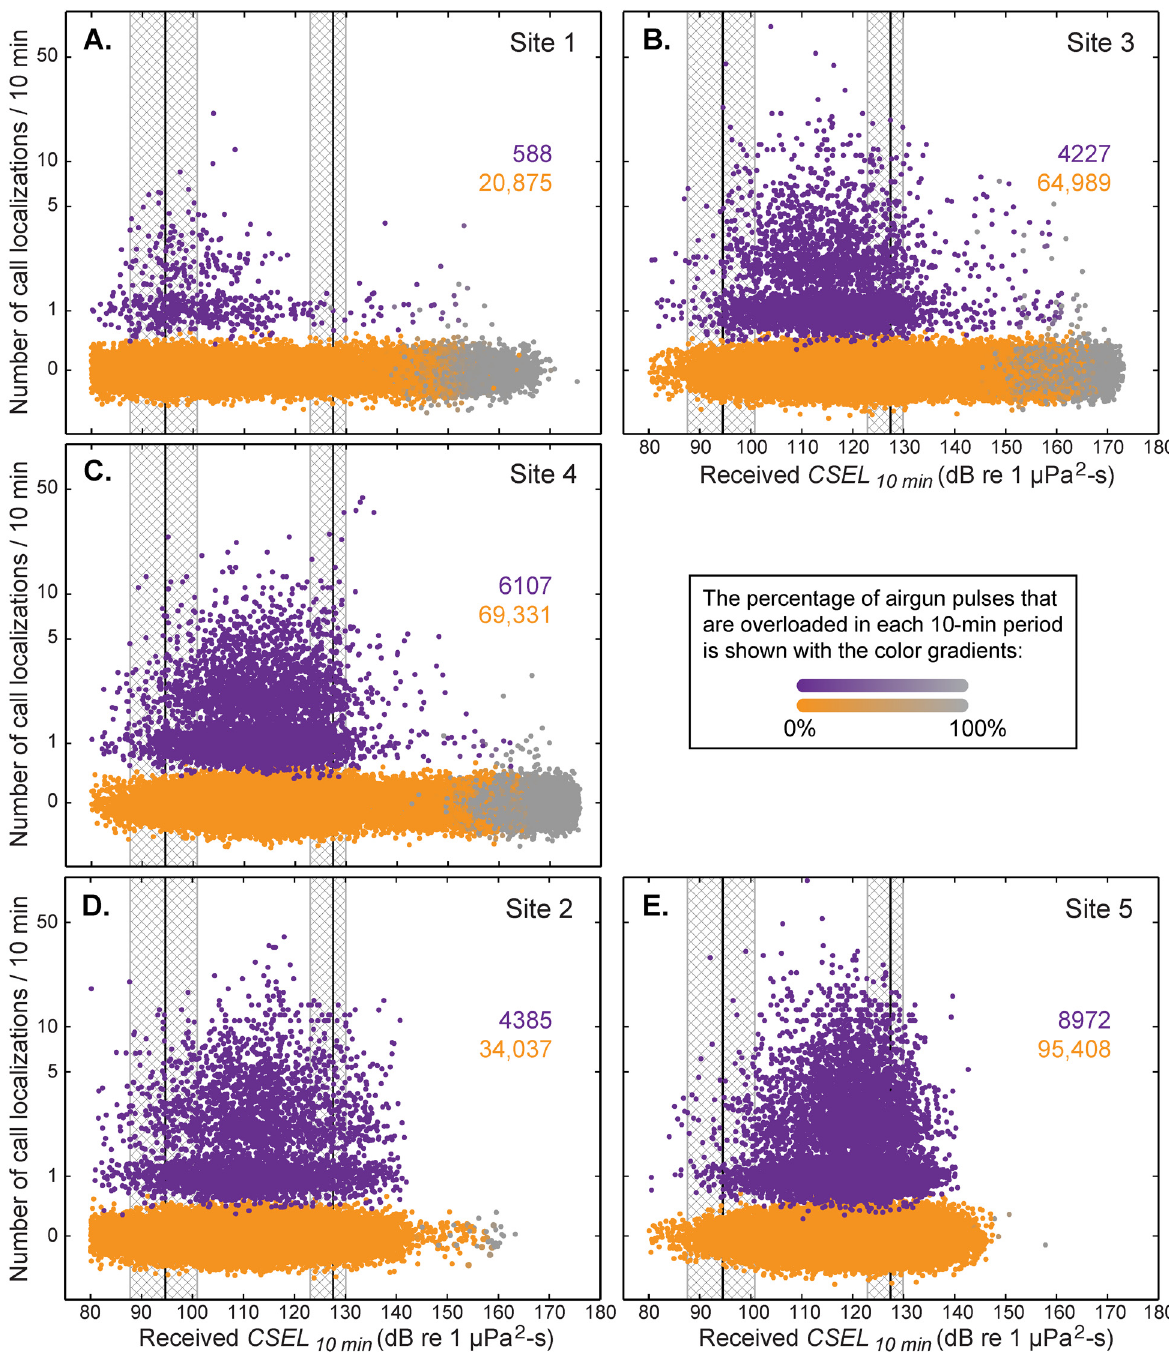
Fig 9. Relative effects of received CSEL 10-min on call localization rate, for all five sites. (A), (B), and (C) (sites 1, 3, and 4, respectively) show the data for sites with nearby airgun use, while (D) and (E) (sites 2 and 5, respectively) show the data for sites that only received relatively distant airgun pulses (see text). All four years of data are combined. Each point represents a cell-time interval, and shows the number of localized calls detected during that time window as a function of the received CSEL 10-min . The two thresholds are shown with black vertical lines and the crosshatched areas are the 95% confidence intervals. The orange and purple numbers in each plot are the numbers of cell-time intervals with zero versus one or more localized calls per 10-min period, respectively. See text for more